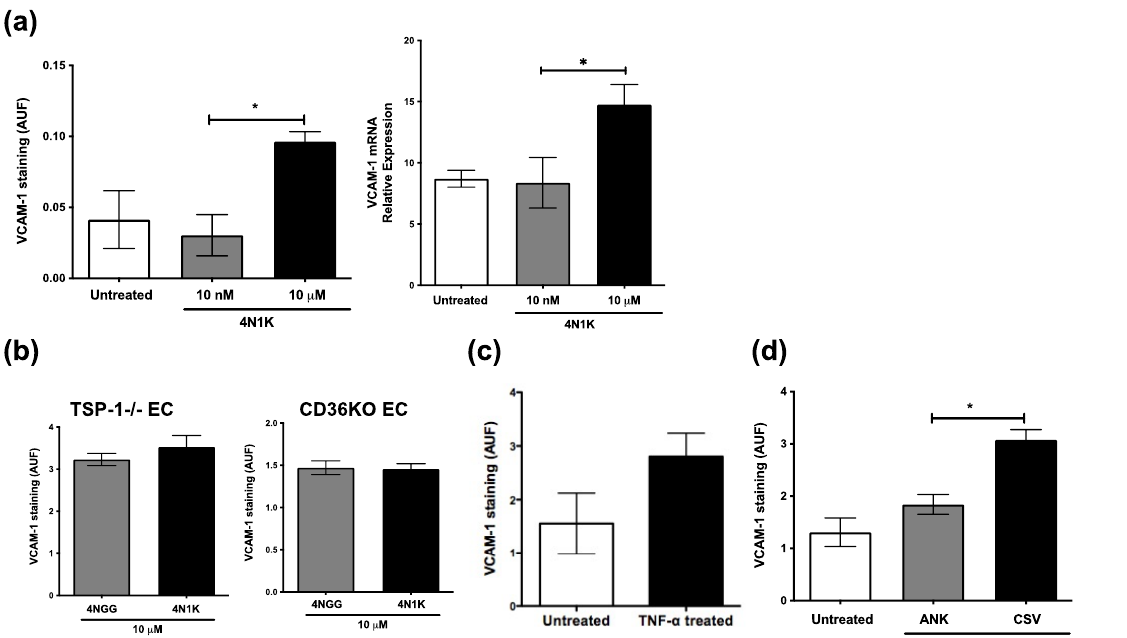
Figure 6. Endogenous TSP-1 from vascular endothelial cells induces increased VCAM-1 expression via CD36. Primary vascular endothelial cell cultures were treated overnight with 10 nM or 10 mM of CD47-binding 4N1K or control peptide 4NGG ( n = 4 per group). ( a ) Peptide-treated WT cells were immunostained for VCAM-1, imaged at 200×, and fluorescence intensities (AUF) were analyzed using ImageJ, and their RNA was analyzed in real-time PCR to detect VCAM-1 message level relative to housekeeping gene GAPDH ( n = 3 reactions per group); ( b – d ) Fluorescence intensity of VCAM-1 immunostaining in endothelial cells (EC) derived from TSP-1- or CD36-deficient mice treated with indicated peptides ( b ); in untreated or TNF- α -treated TSP-1-deficient endothelial cells ( c ) and in WT endothelial cells treated with CD36-binding peptide CSV or control peptide ANK ( d ). Data are presented as the mean values ± SEM. * p < 0.05. Together, these results suggest that VCAM-1 expression on vascular endothelial cells is differentially regulated by two receptors of TSP-1. While increased endogenous TSP-1 expression favors CD36-mediated signaling causing increased VCAM-1 expression, reduced endogenous TSP-1 expression allows for CD47-mediated downregulation of VCAM-1. These results not only explain the dichotomy in our results from those reported previously but also shed light on the opposite roles of TSP-1 in acute vs. chronic inflammation with predominant roles for TNF- α vs. IL -17, respectively.